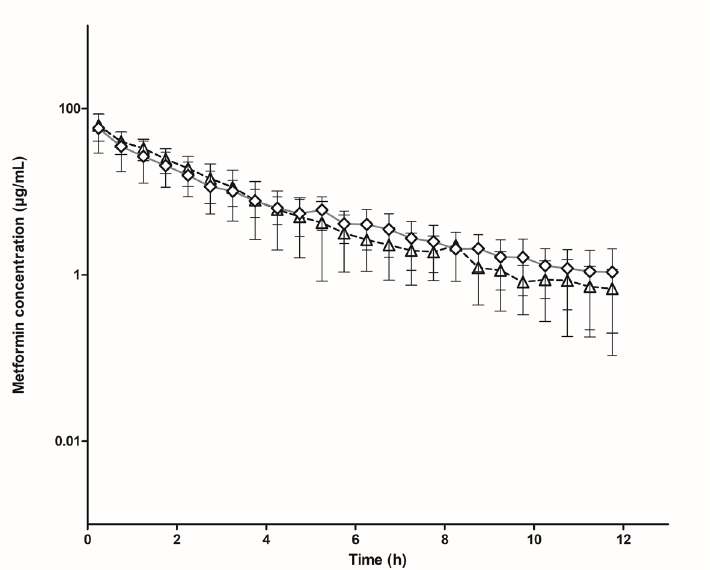
FIGURE 2 - Mean metformin interstitial free concentration versus time profiles after i.v. bolus dose of 50 mg/kg to control (triangle) and diabetic (diamond) rats induced by streptozotocin and nicotinamide. Each point represents mean SD (n =